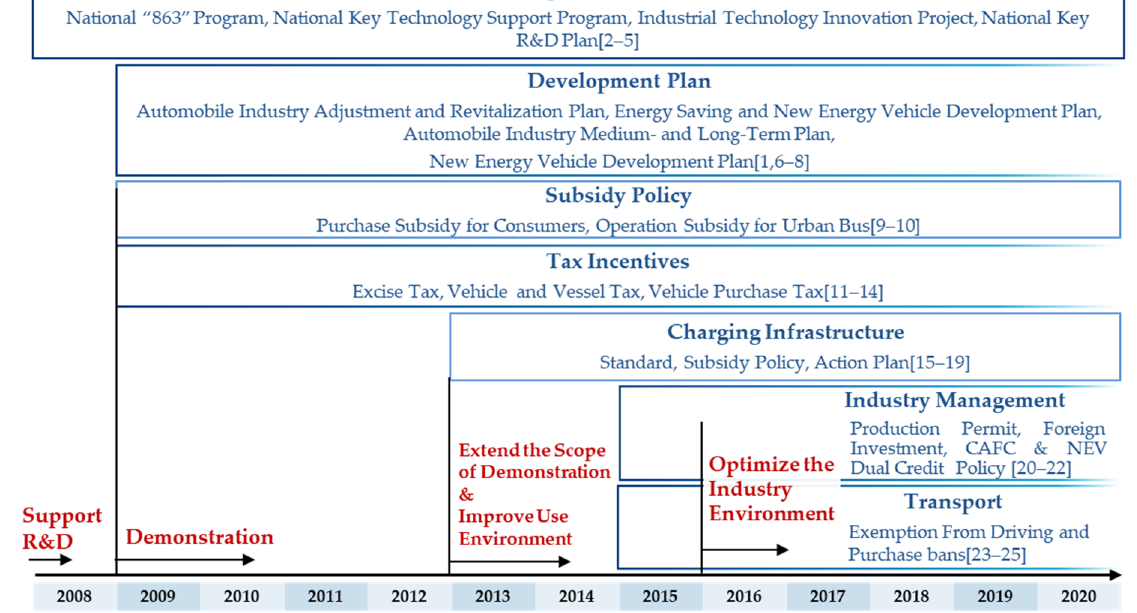
Figure 1. China’s NEV industry-supporting policy system.